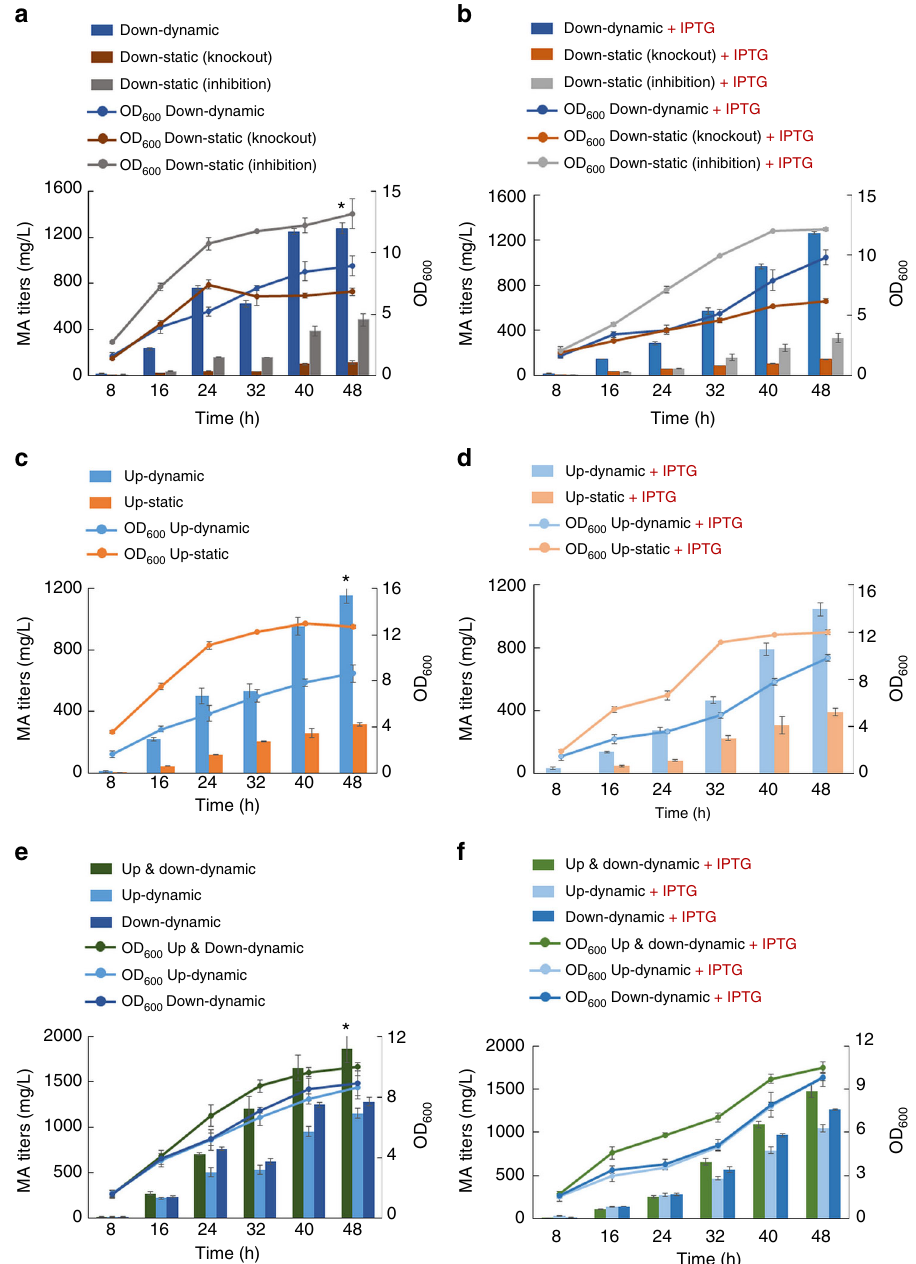
Fig. 3 Implementation of dynamic control for MA production in E. coli BW25113/F ′ Δ pykF Δ pykA (YYP167). a MA production behavior by dynamically downregulating ppc . Down-dynamic: P MA -controlled expression of as ppc (P LlacO1 -EP, P MA -as ppc , YYP167); Down-static (Knockout): ppc disruption (P LlacO1 - EP, YYP167 Δ ppc ) and Down-static (Inhibition): leaking expression of P LlacO1 -controlled as ppc (P LlacO1 -EP, P LlacO1 -as ppc , YYP167). * P < 0.05 is considered to be a statistically signi fi cant increase relative to titers from Down-dynamic in a two-tailed t -test. c MA production behavior by dynamically upregulating EP module. Up-dynamic: P MA -controlled expression of EP module; Up-static: leaking expression of P LlacO1 -controlled EP module (P LlacO1 -EP, YYP167). * P < 0.05 is considered to be a statistically signi fi cant increase relative to titers from Up-dynamic in a two-tailed t -test. e MA production behavior of dynamic upregulation and downregulation. Up & down-dynamic: P MA -controlled EP module and as ppc (P MA -EP, P MA -as ppc , YYP167). * P < 0.05 is considered to be a statistically signi fi cant increase relative to titers from Up & down-dynamic in a two-tailed t -test. The control groups are the dynamic groups of a and c . b , d , f Induced by 0.5 mM IPTG correspond to a , c , e . All the above data from the static group (control) were generated from three biological replicates, all the data from dynamic group were generated from fi ve biological replicates, and error bars represent